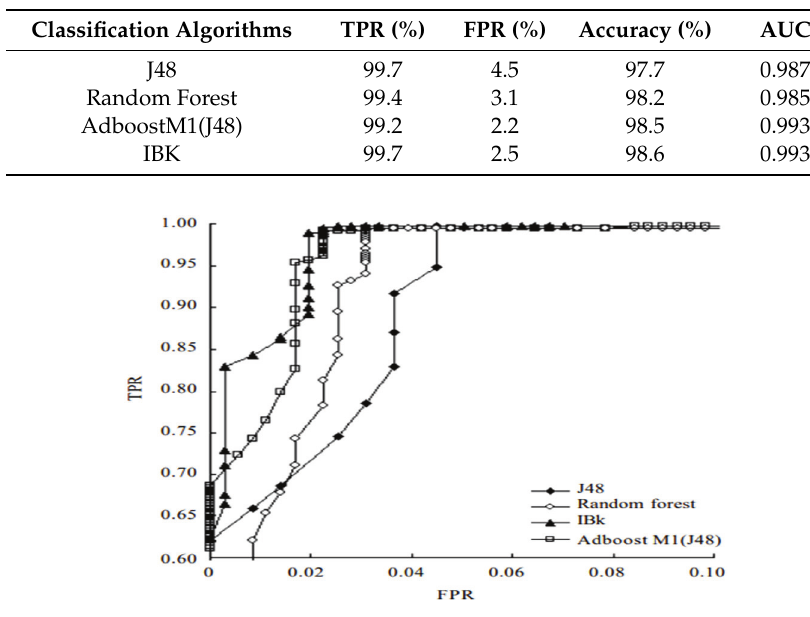
Figure 2. ROC curves for four classification algorithms.